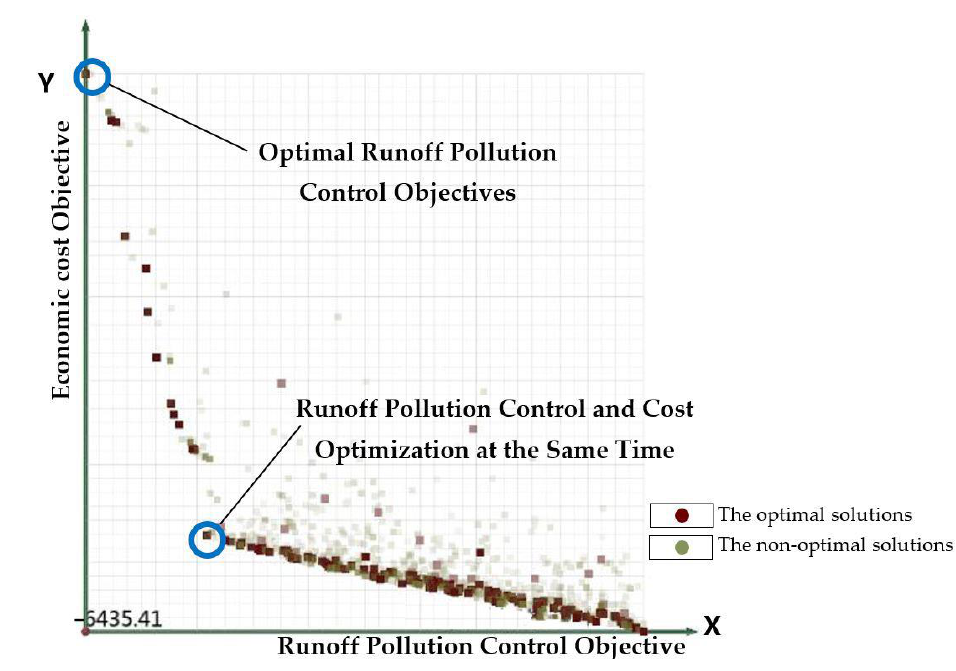
Figure 9. Rainwater infiltration and storage and economic objective are both optimal.